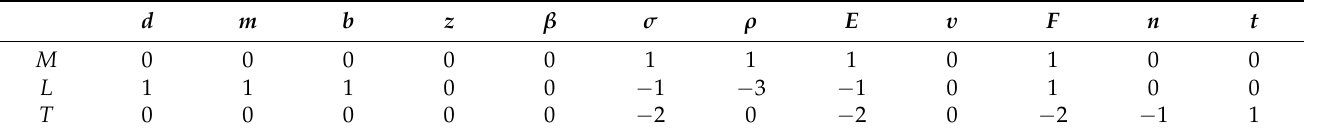
Table 2. MLT system dimension matrix.